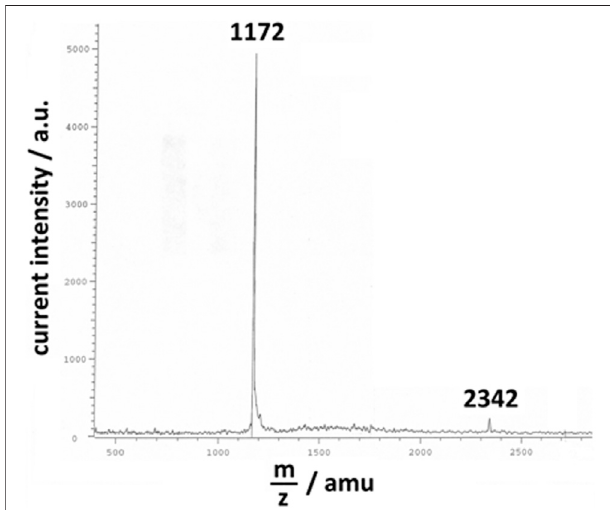
FIGURE 2 | MALDI-TOF spectrum of the fraction of poly-3,3 ″ -DDTT electrodeposit, which is soluble in CHCl 3 . The most intense peaks were detected at 1,172 and 2,342 amu. These values indicate that the CHCl 3 - soluble fraction of poly-3,3 ″ -DDTT was mainly constituted by the dimer and the tetramer of the starting monomer 3,3 ″ -DDTT (with molecular mass 585). In the MALDI-TOF spectrum, the peak associated with the largest mass (not shown) was detected at m / z (cid:1) 4,099, i.e., for the oligomer constituted by seven units of 3,3 ″ -DDTT.